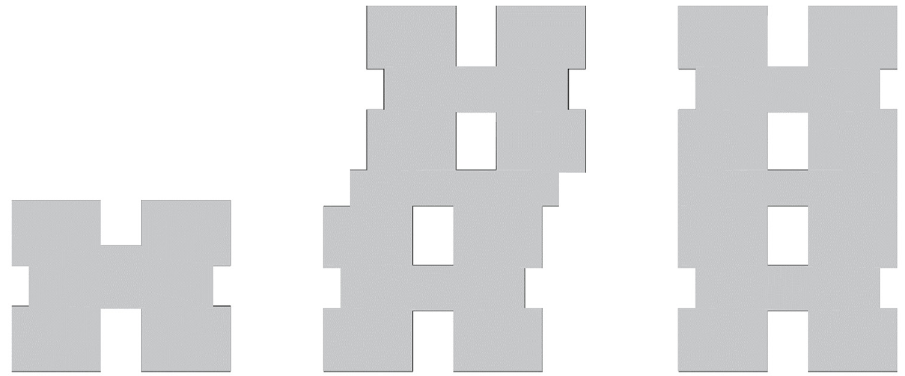
Figure 1. Examples of X or XX-shaped buildings.